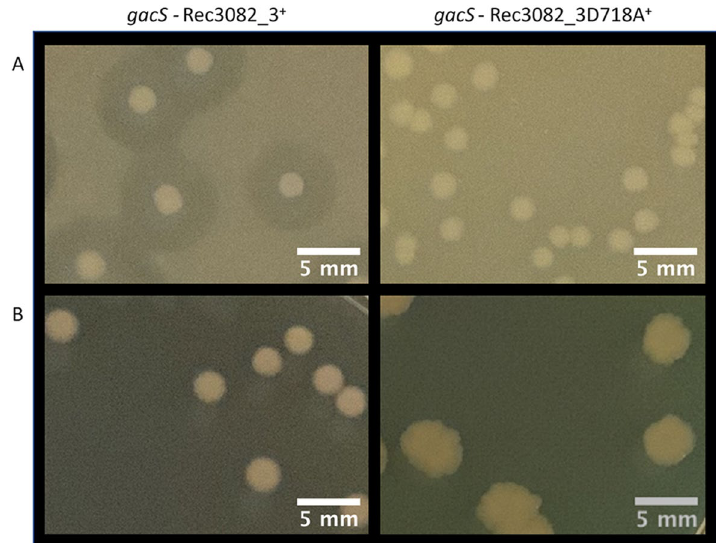
Figure 7. Cross-talk involves the aspartate residue of the transplanted receiver domain. Restoration of the wild-type strain phenotypes by expression of 3082_3 + chimera and lack of restoration by expression of 3082_3D718A + chimera in the gacS mutant. Protease activity on skim milk medium ( A ) and colony appearance on PAF medium ( B